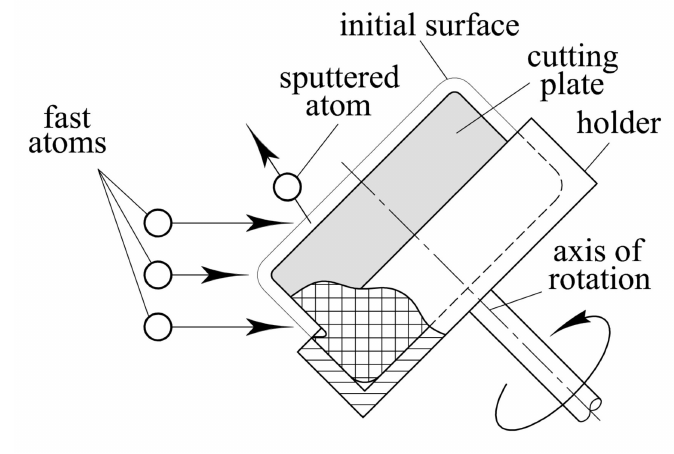
Figure 6. Schematic of etching a cutting plate with fast argon